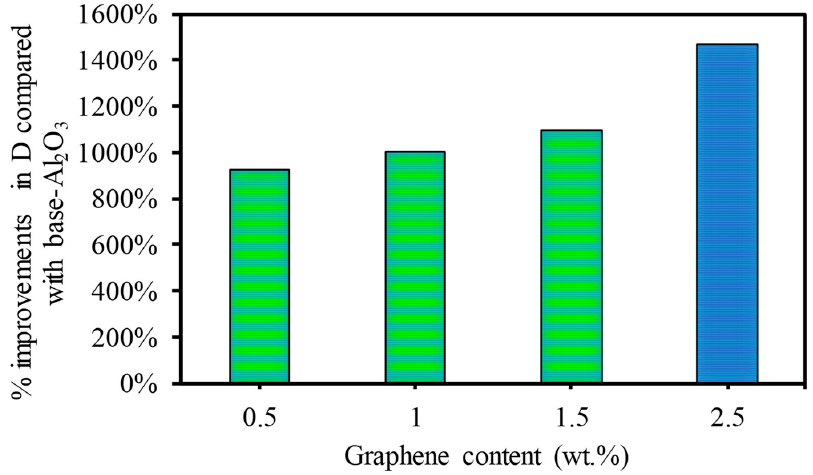
Figure 16. Percentage of improvement in ablation depth at a higher scanning speed of 500 mm/s